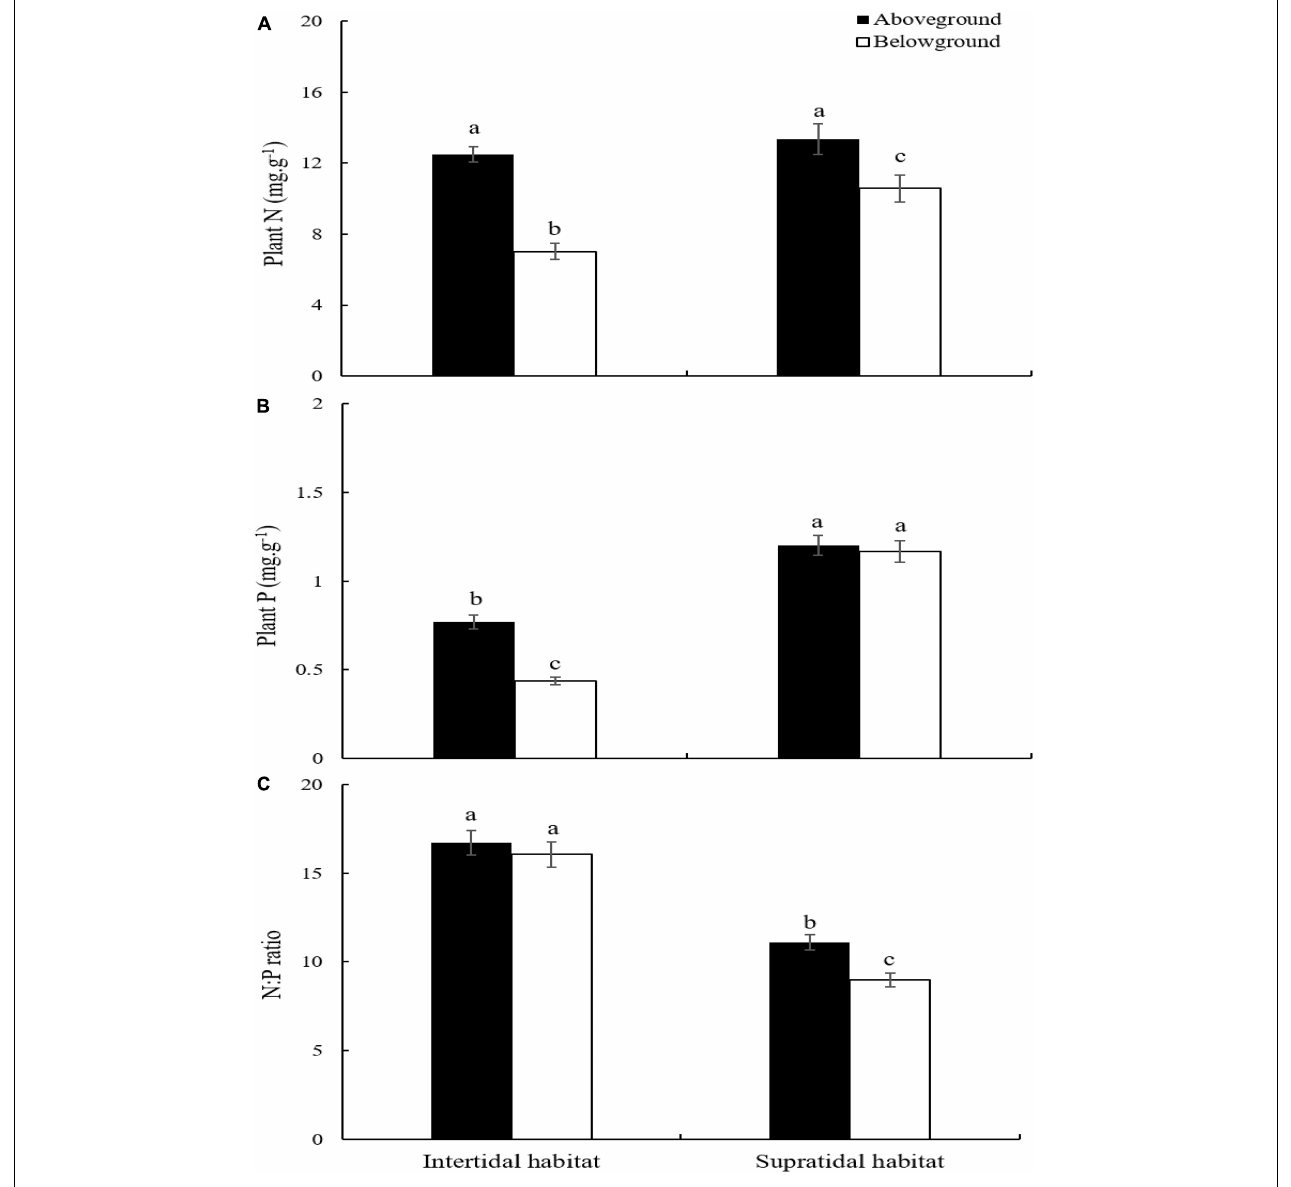
FIGURE 3 | Plant N : P stoichiometry in aboveground and belowground parts of S. salsa at different habitat. (A) N concentration; (B) P concentration; (C) N : P ratio. Different lower-case letters indicate significant differences ( p < 0.05).